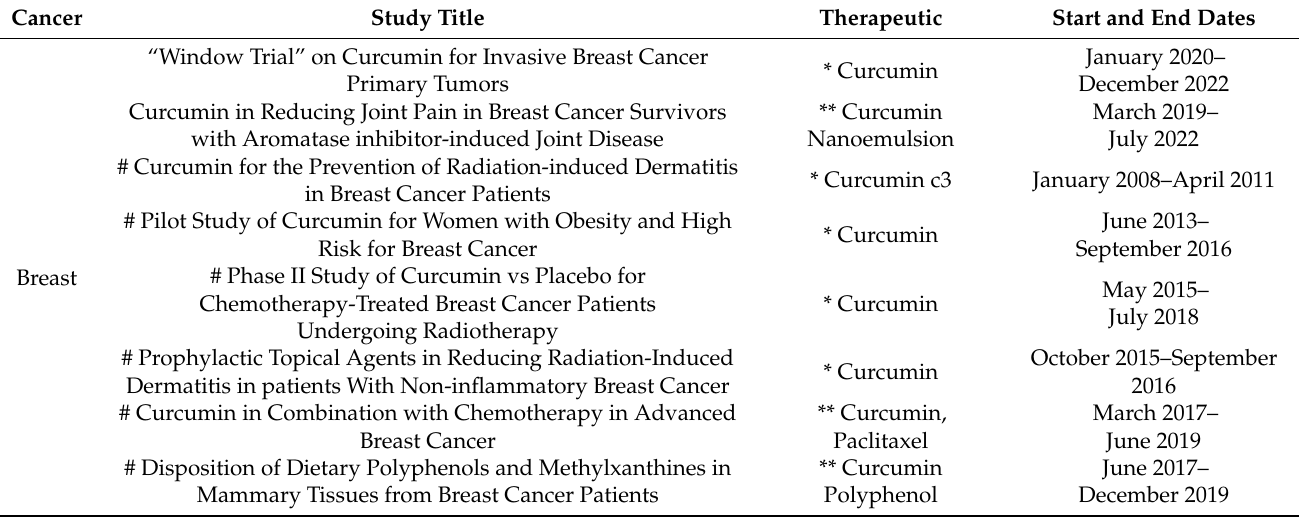
Table 3. Selected completed or ongoing clinical trials from 2004 to date utilizing curcumin in cancer therapy (adapted from